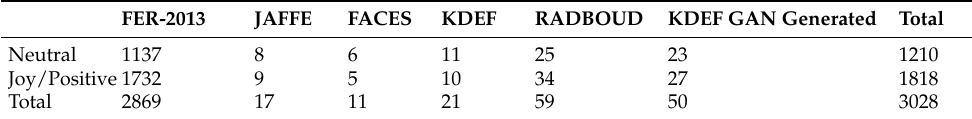
Table 9. Testing Data for Positive and Neutral Classes (Model